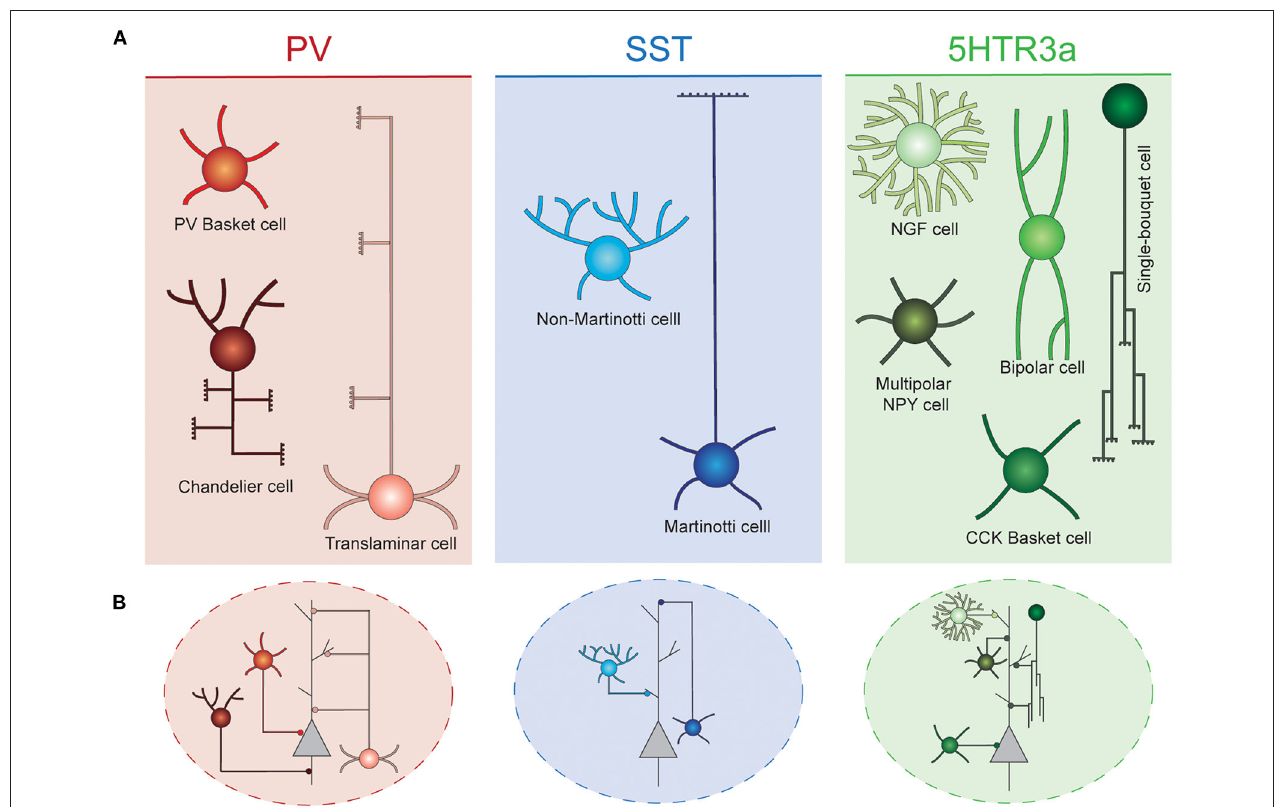
FIGURE 1 | Interneuron diversity in the murine neocortex. (A) Cortical interneurons can be classified into three main classes: PV, SST, and 5Htr3a. Each of these classes can be further subdivided into different types. (B) Different interneuron types preferentially target specific compartments of surrounding projection neurons. Basket cells target their soma. Chandelier cells specifically innervate axon initial segments. SST and 5Htr3a cells mostly target projection neuron dendrites at different levels. PV, parvalbumin; SST, somatostatin; NGF, neurogliaform; NPY, neuropeptide Y; CCK,